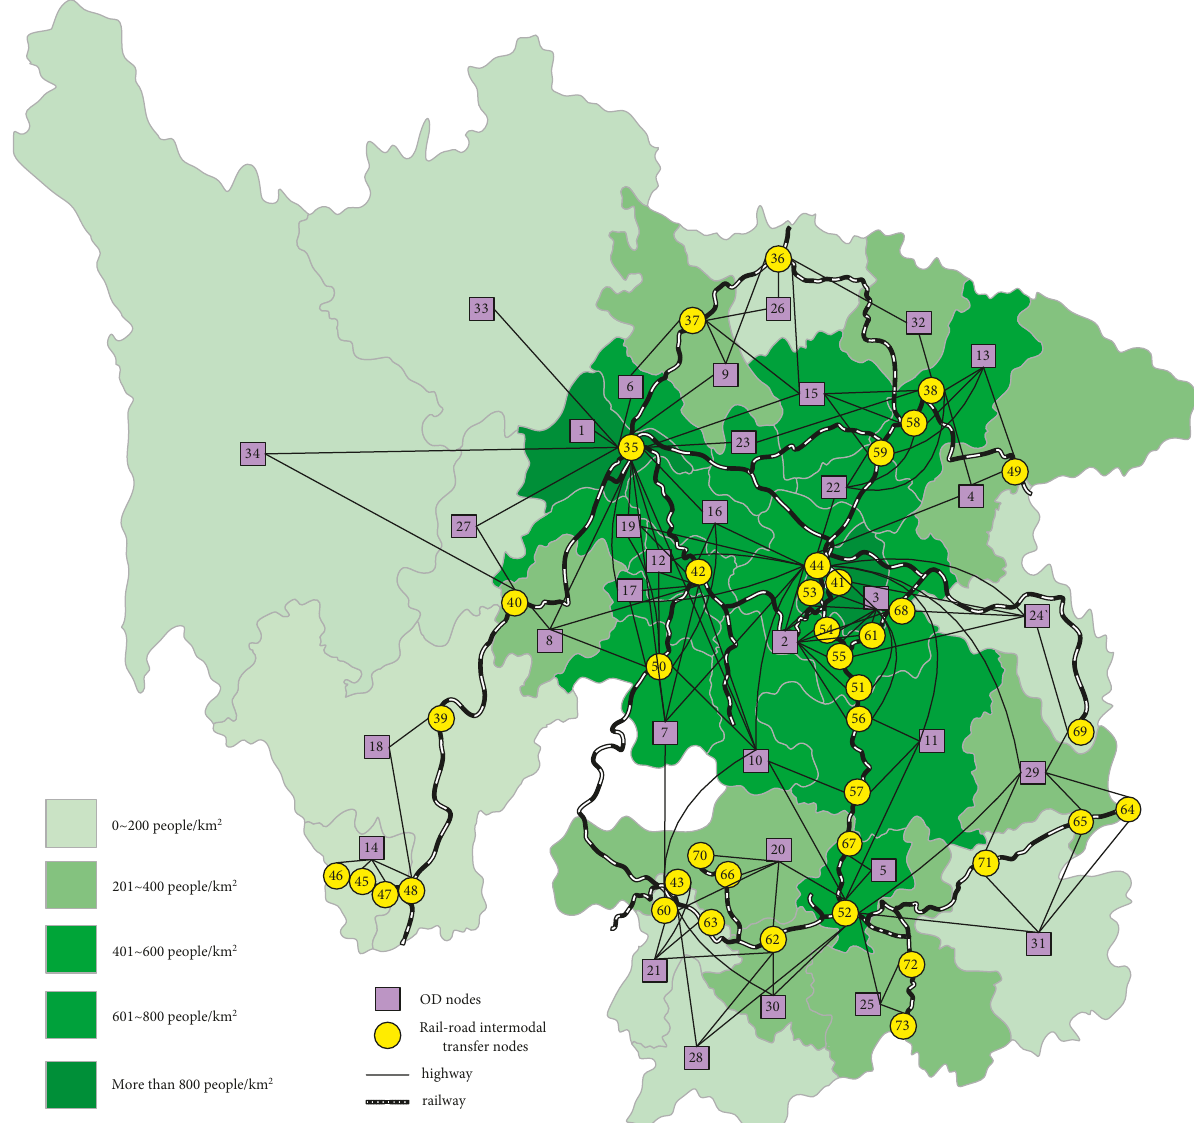
Figure 4: Railroad intermodal transportation physical network of the studied